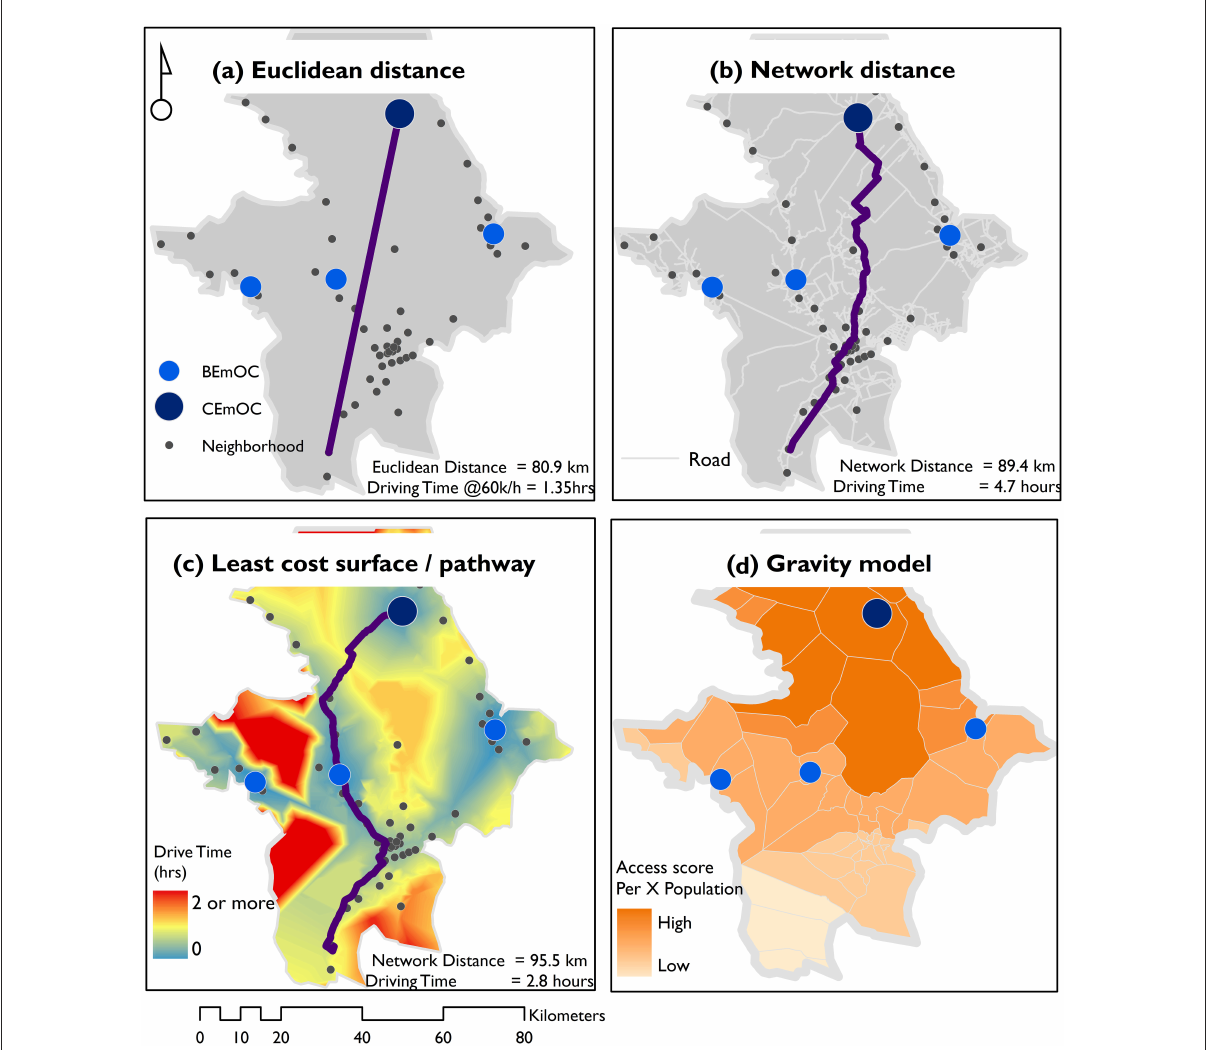
FIGURE1 Common methods for estimating travel time to health facilities in LMICs. An illustration of common approaches used to compute geographic access to health service providers in LMICs including (a) , Euclidean distance, (b) network distance, (c) least cost path distance, and (d) gravity